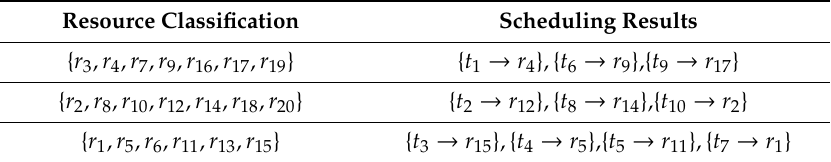
Table 4. User requirements and resources matching results.